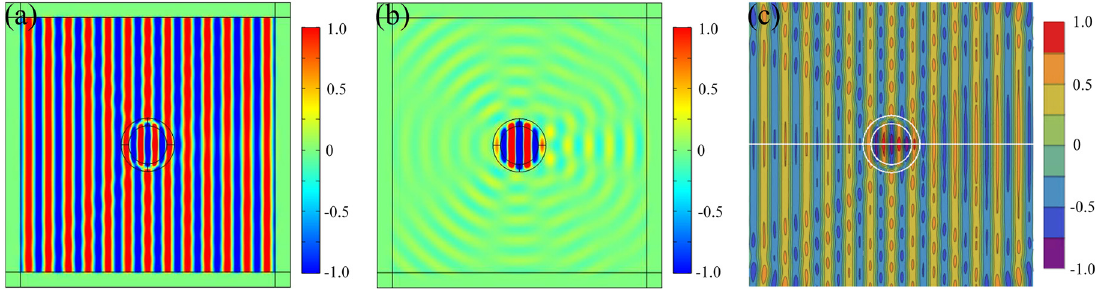
Figure 3: Numerical simulations of (a) H z component diagram and (b) scattering magnetic fi eld diagram based on α -MoO 3 invisibility concentrator. (c) Analytical calculations of H z component diagram based on α -MoO 3 invisibility concentrator.